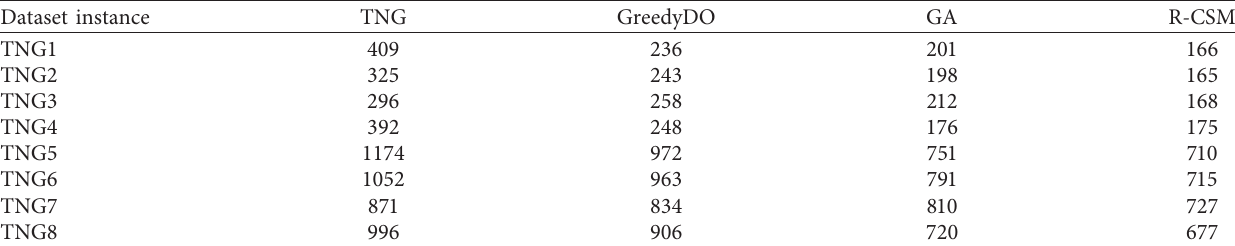
Table 11: Makespan of GreedyDO, GA, and R-CSM (in